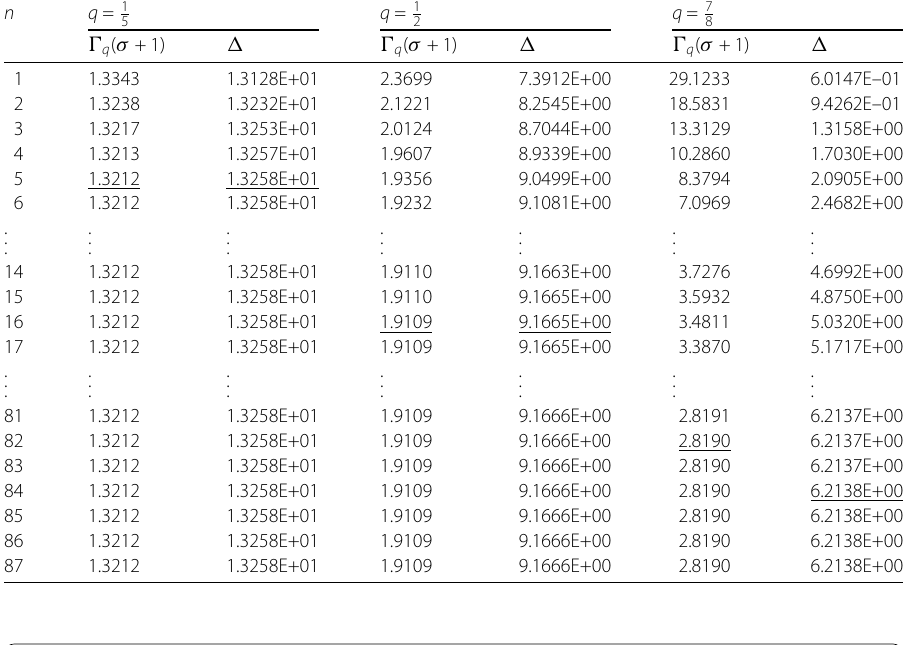
, 1 , 7 in Example 4.2 (Algorithm 1) 5 2 8